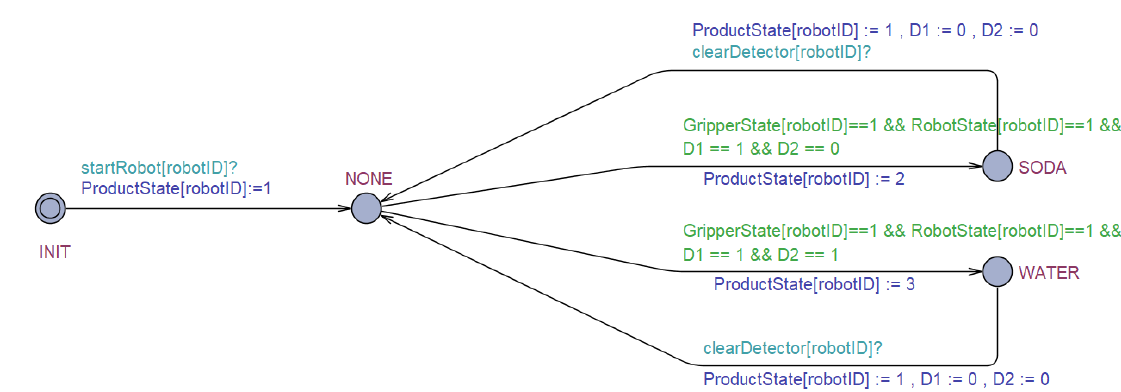
Figure 10. UPPAAL timed automata model of product detector.